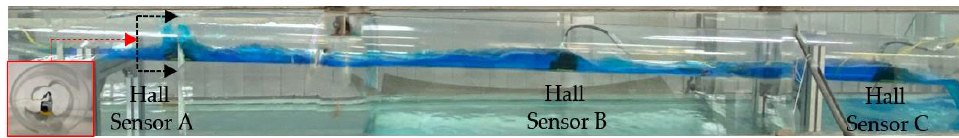
Figure 3. Experimental equipment of miniaturized subsea pipeline with hall sensors.